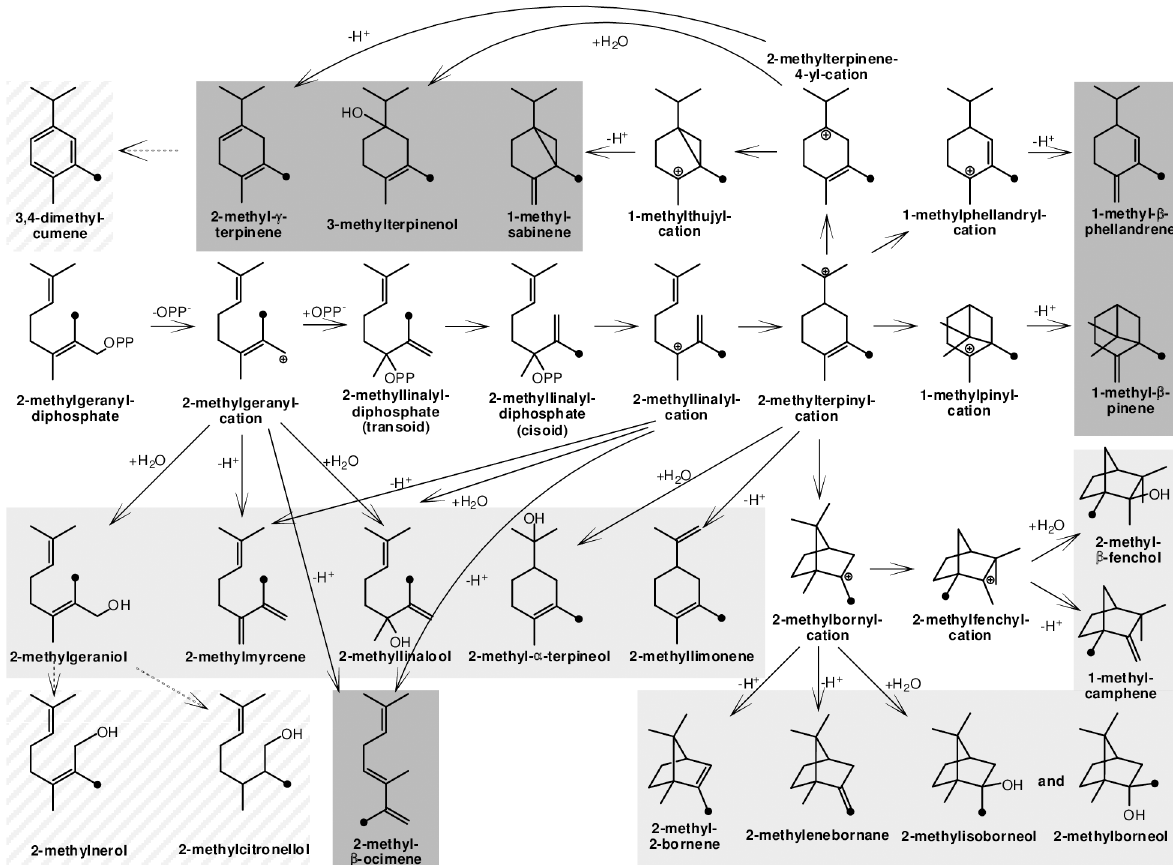
Fig 6. Proposed reaction mechanism of C11-terpenes catalyzed by C11-TSs based on Brock et al. [22]. Methyl groups introduced by the GPP-MTase are labeled with a black dot. Potential, but not detected products have a dark gray background. Products detected in this or other studies have a light gray background. Compounds that have been detected, but are no direct terpene synthase products have a hatched background.